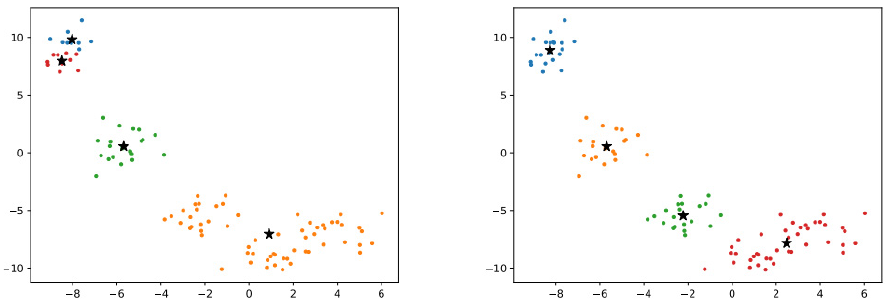
Figure 8. Example of logical (graph on the right) and illogical (graph on the left) clustering using K-mean.